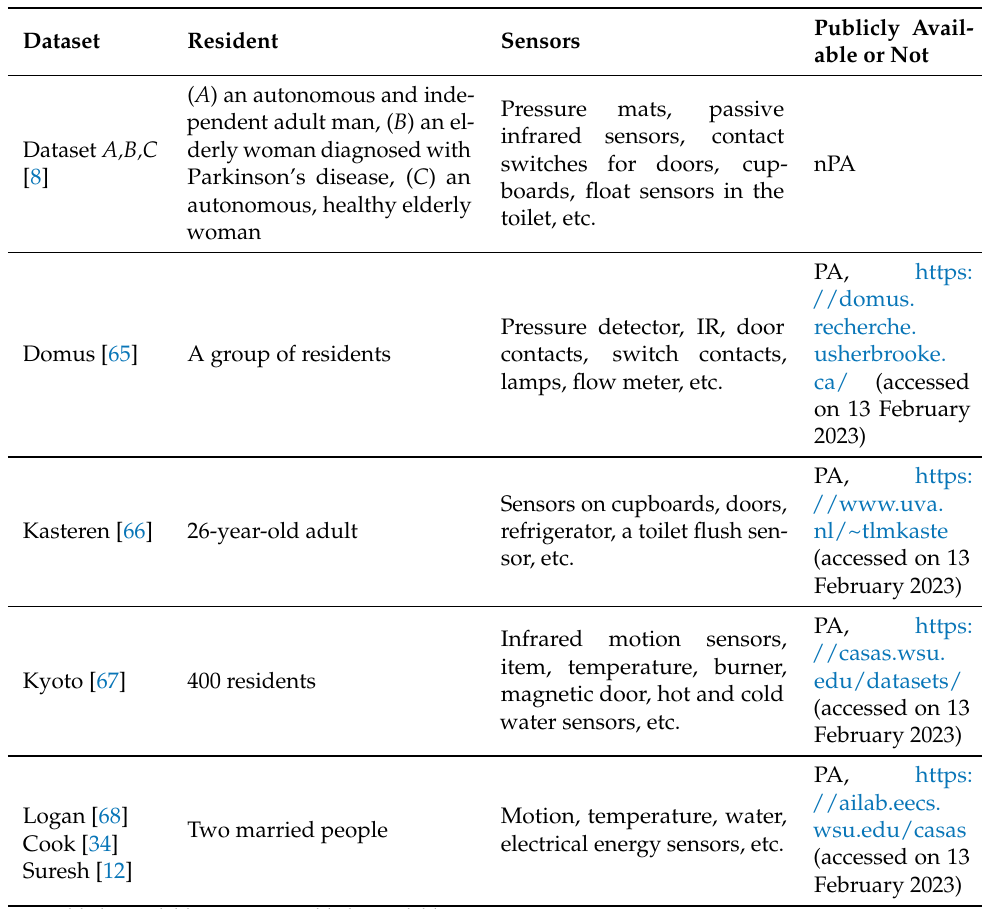
Table 4. A summary of sensor-based SE